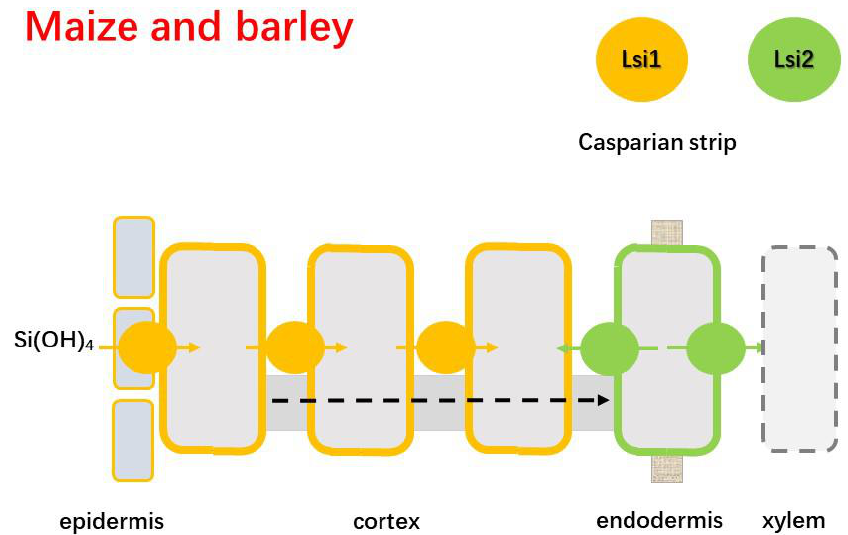
Figure 2. Schematic model of the Si transport system in both maize and barley.